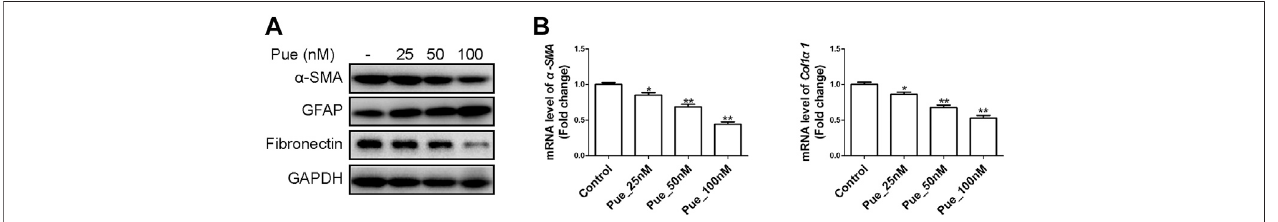
FIGURE 6 | Puerarin inhibited the activation of HPSCs. (A) The protein expression levels of α -SMA, GFAP and Fibronectin were tested in HPSCs after treatment withdifferentdosesofpuerarin(25,50,100 nM)for24 hbyWesternblottinganalysis. (B) ThemRNAexpressionlevelsof α -SMAandCol1 α 1weretestedinHPSCsafter treatment with different doses of puerarin (25, 50, 100 nM) for 24 h by qRT-PCR analysis. * p < 0.05, ** p < 0.01 vs. control.